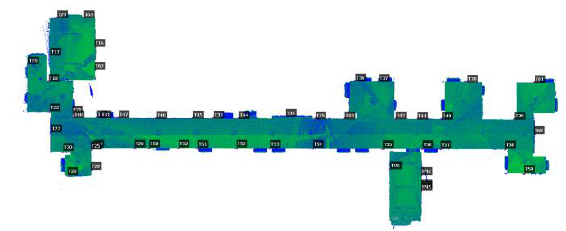
Figure 8. Distribution of targets in the test area.